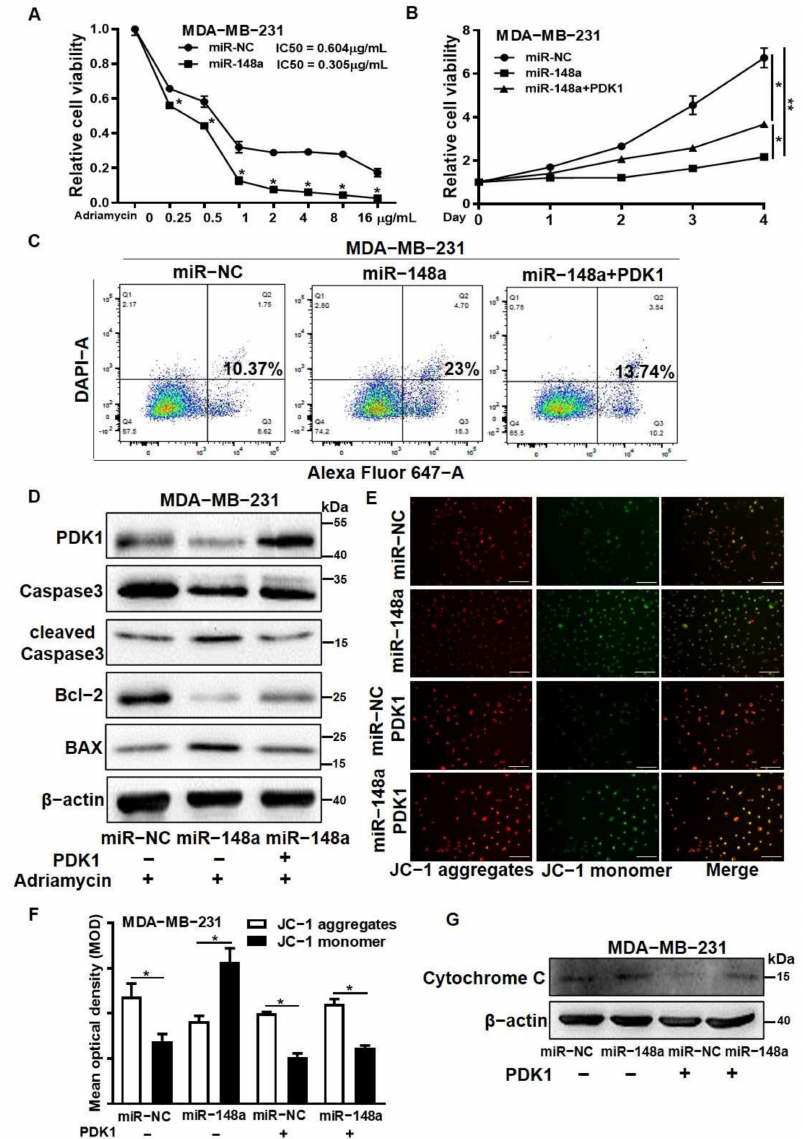
Figure 6. PDK1 overexpression reversed the effect of miR-148a decreasing Adriamycin resistance. Co-transfection of miR-148a and PDK1 lentivirus plasmid was performed in MDA-MB-231 cells to obtain double-overexpression stable cells. The following experiments were performed in the MDA- MB-231 miR-NC, miR-148a, and miR-148a + PDK1 groups. ( A ) The IC50 values of the MDA-MB-231 miR-NC and miR-148a groups treated with Adriamycin (0–16 µ g/mL) were measured using CCK8 assays ( n = 4). ( B ) The proliferative abilities of MDA-MB-231 miR-NC and miR-148a cells were detected under Adriamycin treatment (0.15 µ g/mL) by CCK8 assays ( n = 4). ( C ) Flow cytometry was used to measure the apoptosis levels in the three groups under Adriamycin treatment (0.3 µ g/mL). ( D ) Western blotting was used to detect the protein expression levels of BAX, Bcl-2, cleaved Caspase3, Caspase3, and PDK1 in MDA-MB-231 cells treated with 0.15 µ g/mL Adriamycin (three independent experiments performed in triplicate). ( E ) Mitochondrial membrane potential (MMP) changes were measured using the fluorescent probe JC-1 in the four groups. Representative immunofluorescence images (200 × ) are shown. Red represents JC-1 aggregates and green represents JC-1 monomer. ( F ) The results in ( E ) were quantified by calculating the image mean optical density (MOD). ( G ) The levels of Cytochrome C in cytoplasm were measured by Western blotting. Student’s t -test was used for comparison between two groups, bar = 50 µ m. * Indicates significant difference at p < 0.05 and ** indicates significant difference at p < 0.01. Original Blots see Supplementary File